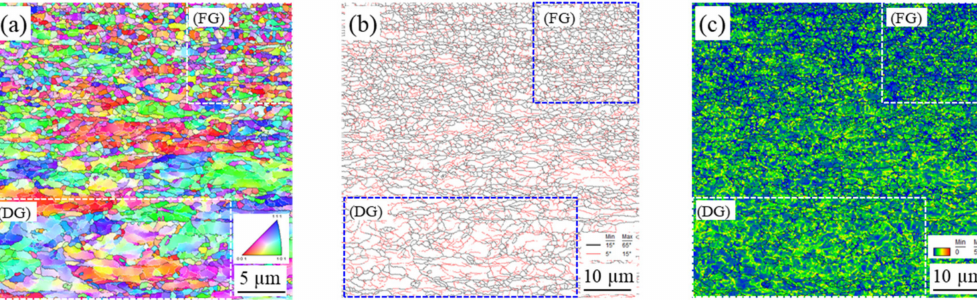
Figure 11. EBSD characterization at the transient area from fine-grained (FG) to deformed-grained (DG) near the top surface of sample A: ( a ) inverse pole figure; ( b ) grain boundary; and ( c ) kernel average misorientation (KAM).